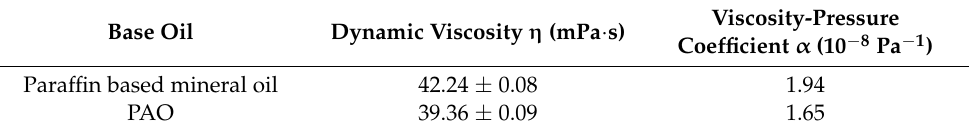
Table 2. The basic parameters of base oil at 40 ◦